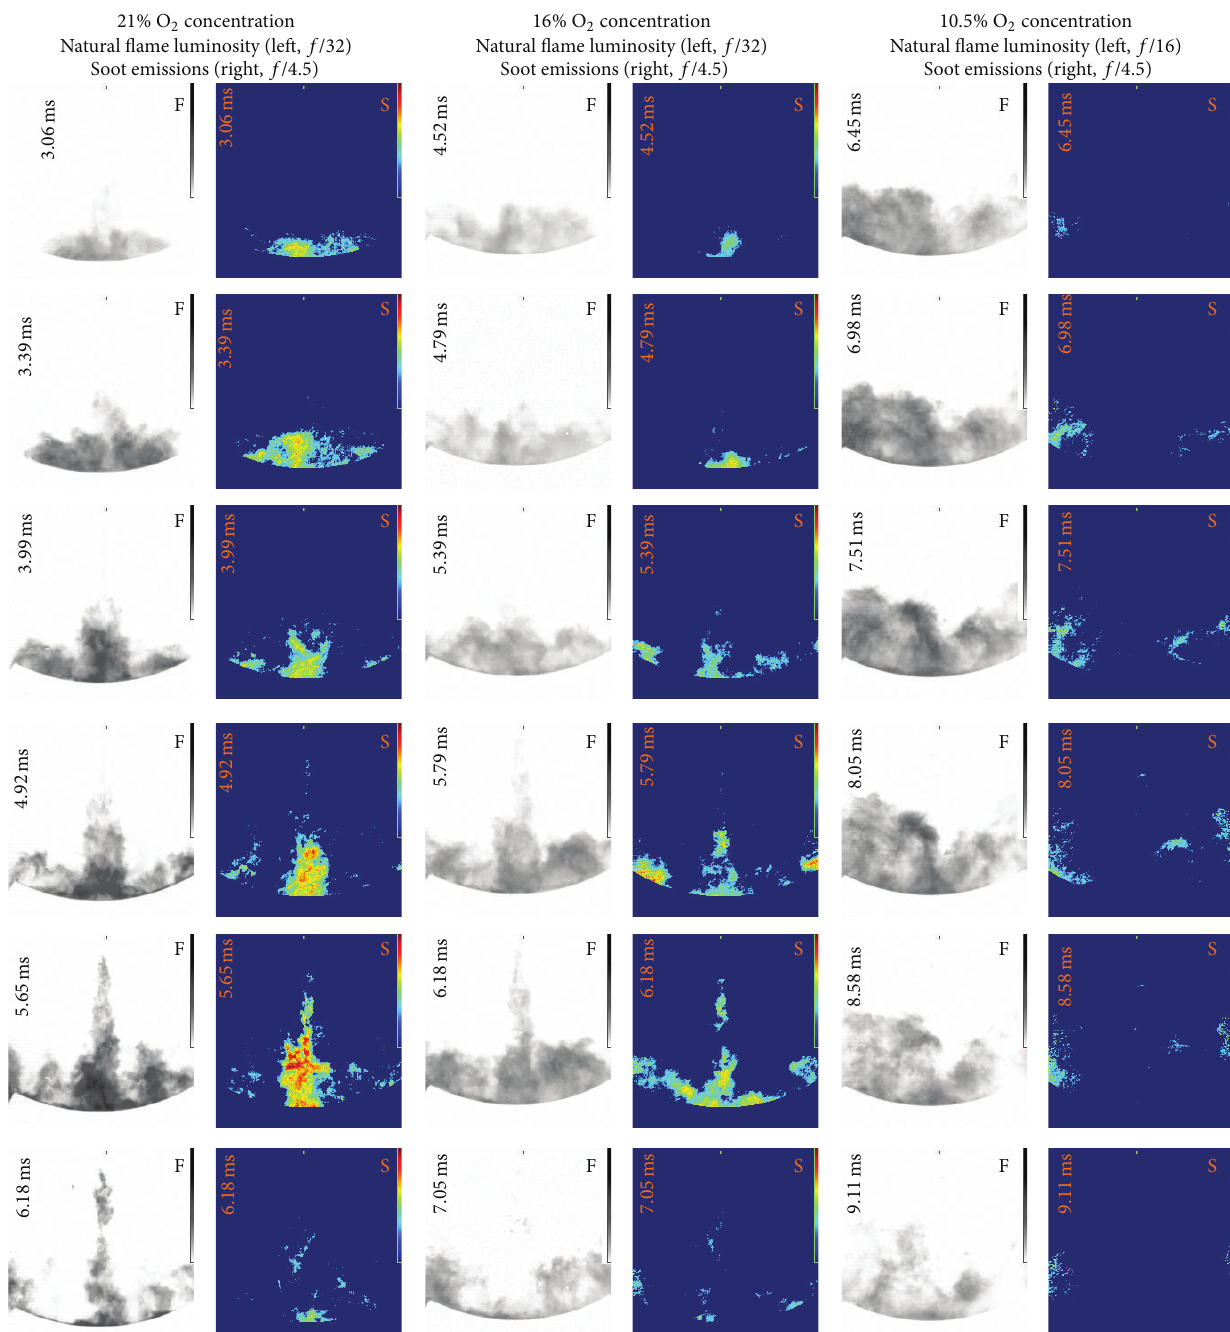
Figure 14: Natural flame luminosity and soot distribution for soybean biodiesel at 800 K ambient temperature [68].